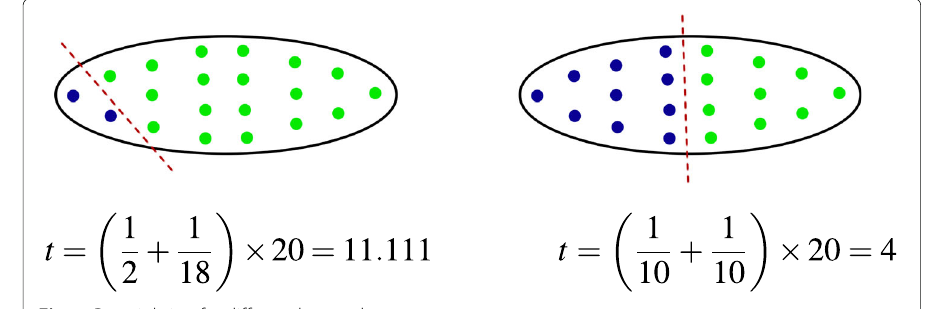
Fig. 1 Reweighting for different hyperedge